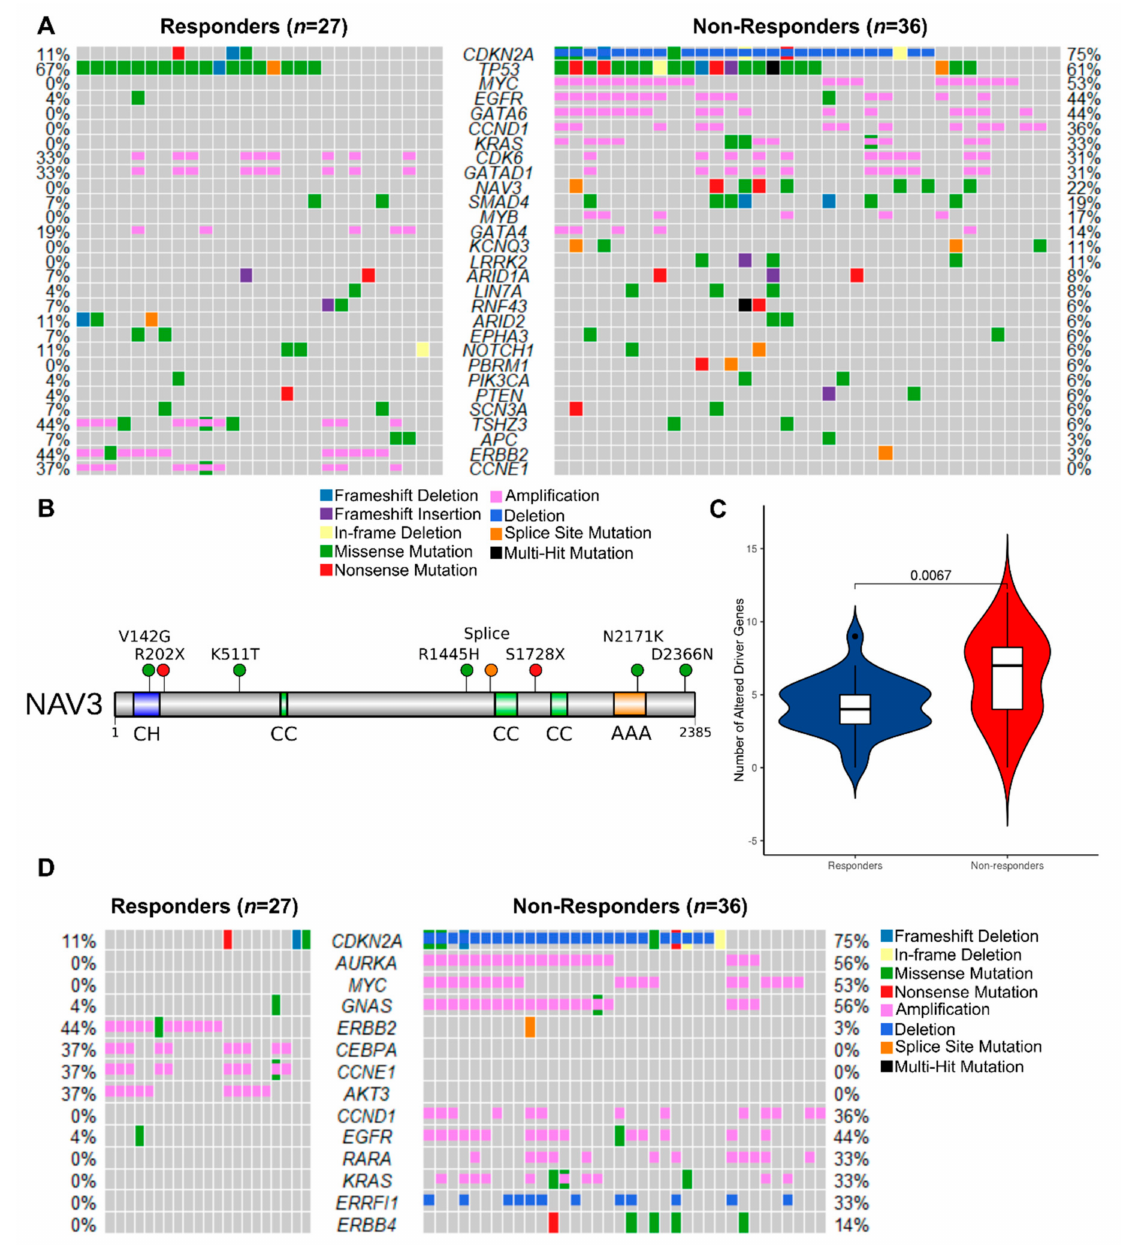
Figure 5. Non-responders have more EAC driver alterations of all types, including exclusive mutation of the tumor suppressor NAV3 . ( A ) Oncoplot of SNVs, indels and CNVs combined in responders vs. non-responders ( n = 63). Genes shown are the subset of the 76 EAC driver genes described in Frankell et al. [25] that were mutated in at least 5% of either group. Percentages of responders or non-responders with driver gene mutations are shown next to the corresponding row. ( B ) Protein-level diagram of mutations in the coding sequence of NAV3 , which was exclusively mutated in non-responders. Domains are labeled as follows: CH—calponin homology; CC—coiled coil; AAA—ATPase associated with diverse cellular activities. Mutational sites are shown as lollipops color-coded according to the type of mutation. ( C ) Violin plots comparing frequency of all alterations (SNVs, indels and CNVs) in EAC driver genes per sample in responders vs. non-responders. ( D ) Oncoplot of SNVs, indels and CNVs combined in TARGET database genes, which are associated with a clinical action in cancer ( n = 63). Genes that were mutated in at least 5% of either group are